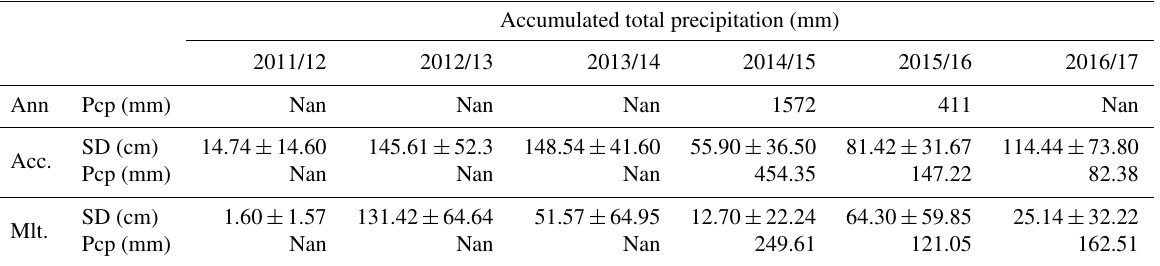
Table 7. Accumulated precipitation (liquid and solid) for snow seasons with observations available. Average snow depth values for accumu- lation and melt periods for the five snow